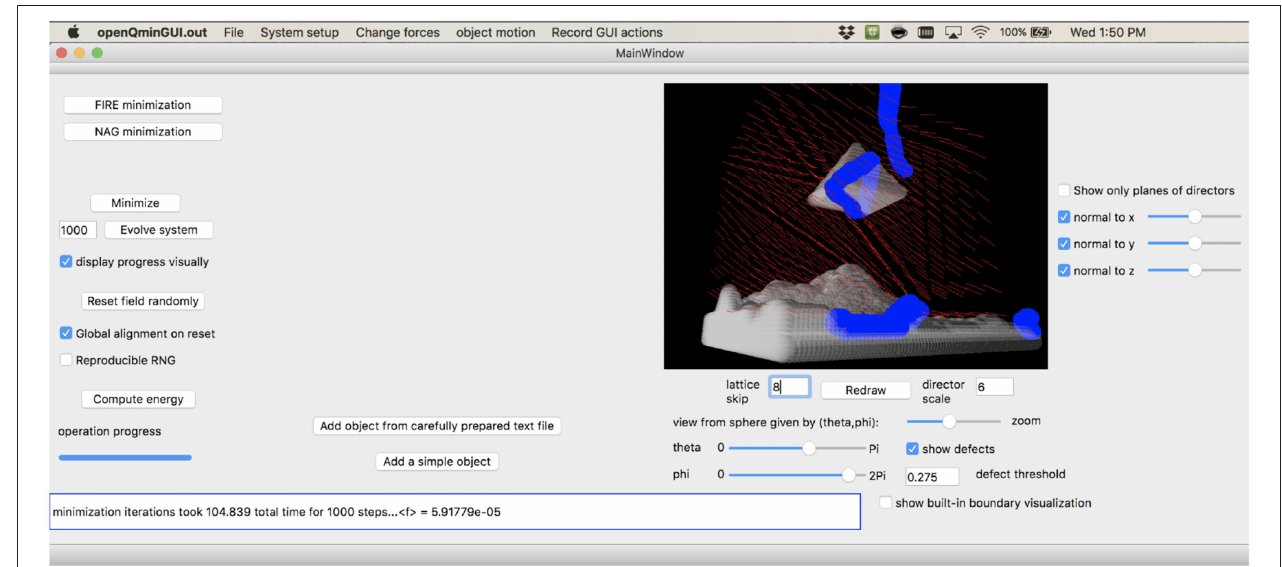
FIGURE 1 | Snapshot of the graphical user interface provided by openQmin , here shown simulating the defect structure near a pyramidal colloid above a topographically non-trivial boundary, all with oriented anchoring along user-specified directions to approximately model homeotropic